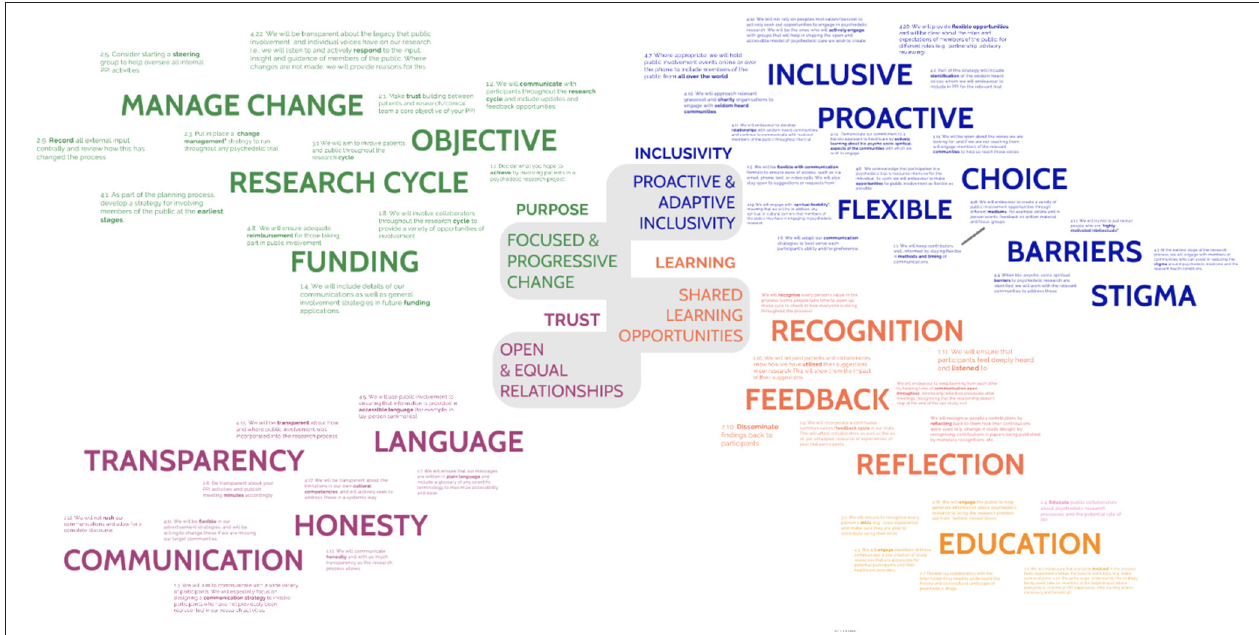
FIGURE 2 | A scaled version of the conceptual map of content from the co-design workshop. Themes are grouped into four distinct but interrelated areas defined by core values of trust, purpose, inclusivity, and learning.